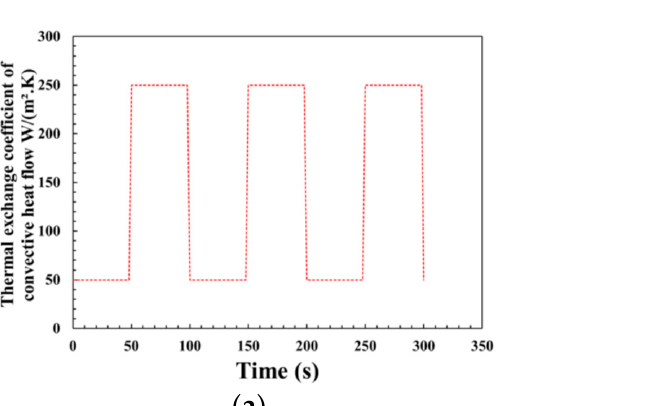
Figure A6. Convective heat flow on ( a ) external specimen and internal air-cooled specimen, ( b ) external nut and jaw + external grip, ( c ) internal jaw and internal air-cooled nut, ( d ) external copper clip; ( e ) fixed 20 ◦ C temperature as continuous water cooling; ( f ) radiant surfaces; ( g ) thermal contact at the interfaces.